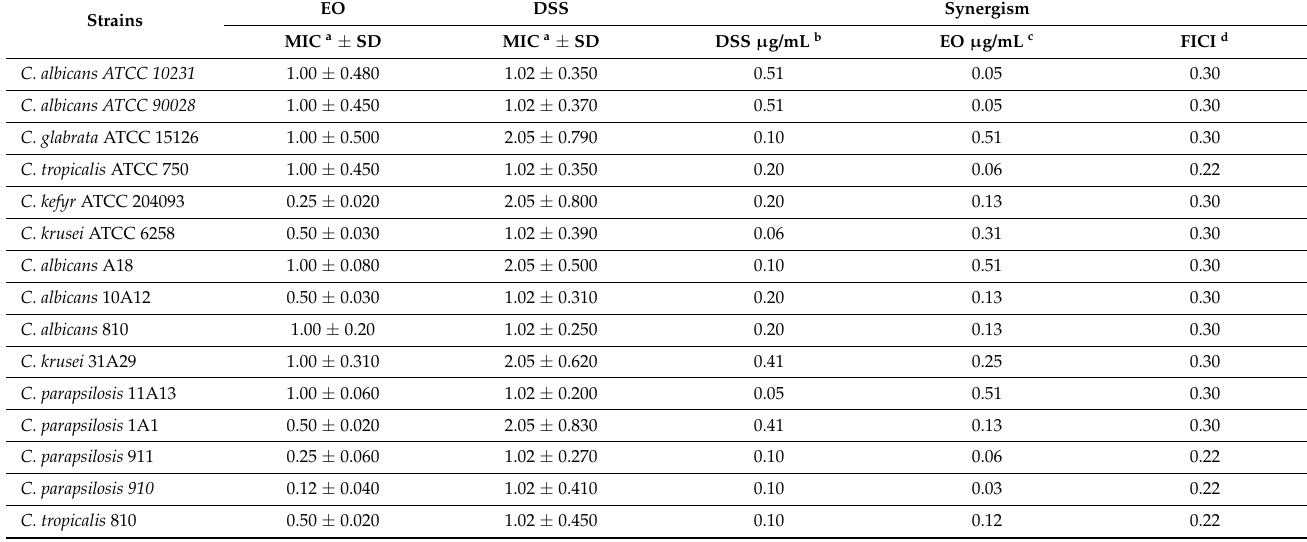
Table 2. Antifungal activity of M. piperita Essential Oil (EO) and Diclofenac Sodium Salt (DSS) on different Candida strains. EO Strains